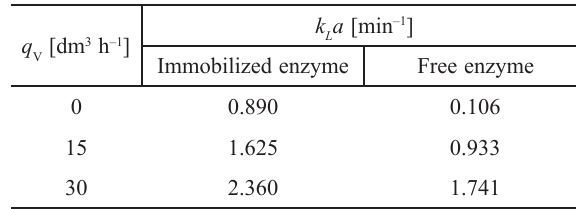
Table 3 – Oxygen volume transfer coefficients, k ent air flow rates in the batch reactors (30 °C, 0.1 M phosphate buffer pH 7, immobilized enzyme: shaker, 30 cm 3 ; free